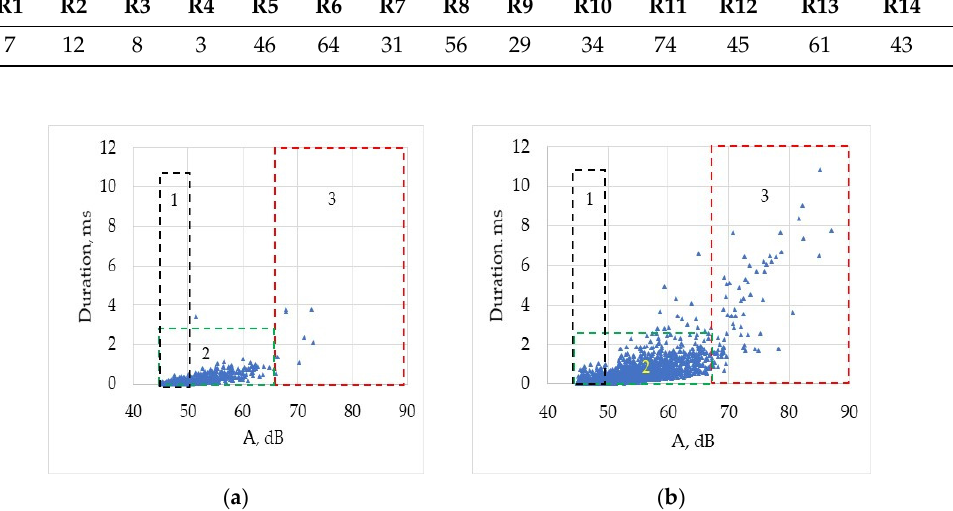
Figure 12. Scatterplots AE hit durations vs. AE hit amplitudes for defect-free specimens ( a ) and for defective specimens ( b ). Area 1 localized noise of the loading machine (black rectangle), area 2—structural noise (green rectangle), area 3—defects (red rectangle).